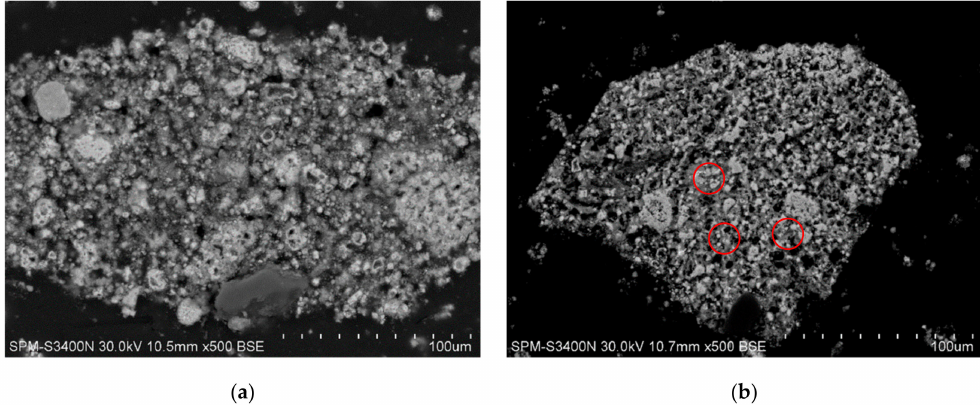
Figure 12. SEM micrographs of the materials before and after roasting. ( a ) Raw material and ( b ) microwave heating